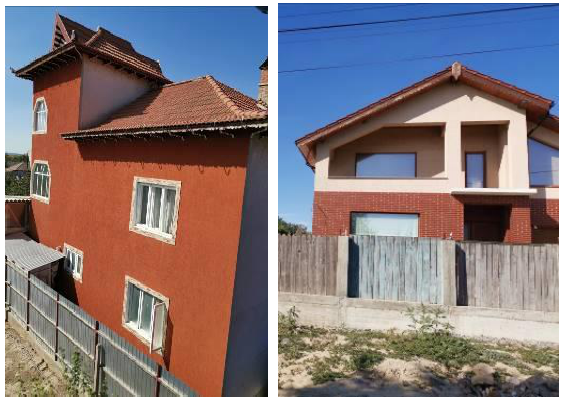
Figure 10. Contemporary houses in Sarichioi village.